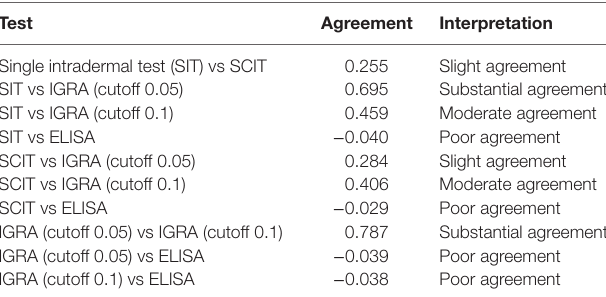
TaBle 2 | Agreement between tests in all animals 2 months after booster vaccination (kappa index, k ). Test agreement interpretation Single intradermal test (SIT) vs SCIT